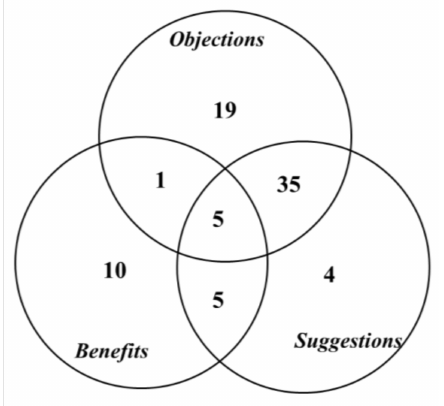
Figure 3. Venn diagram showing the numbers of people with overlapping perceptions of the RUGA